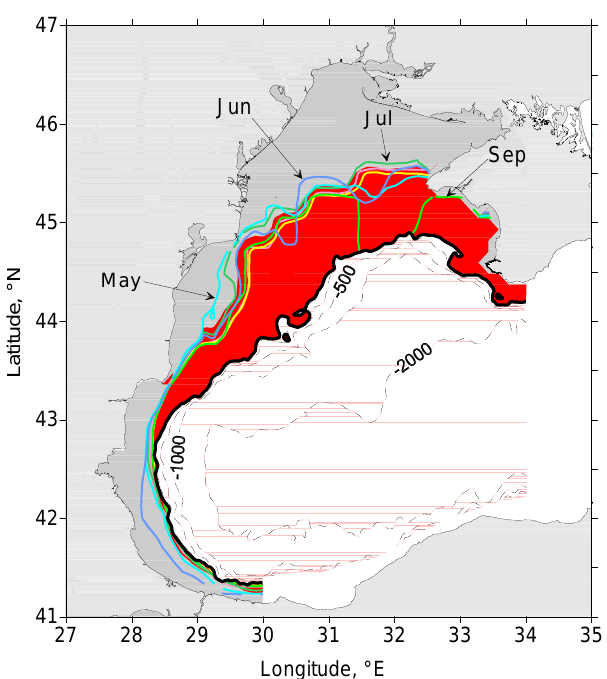
Fig. 4. Shelf area covered by BSW ( σ θ ≥ 14 . 2kgm − 3 ) for the in- dividual months from May to November. The extent in August is shaded in red, while the slight deviations in other months are shown by super-imposed contour lines, several of which are individually labelled. The bold line is the shelf boundary along the 150m iso- bath, dashed lines are isobaths at 200, 500, 1000 and